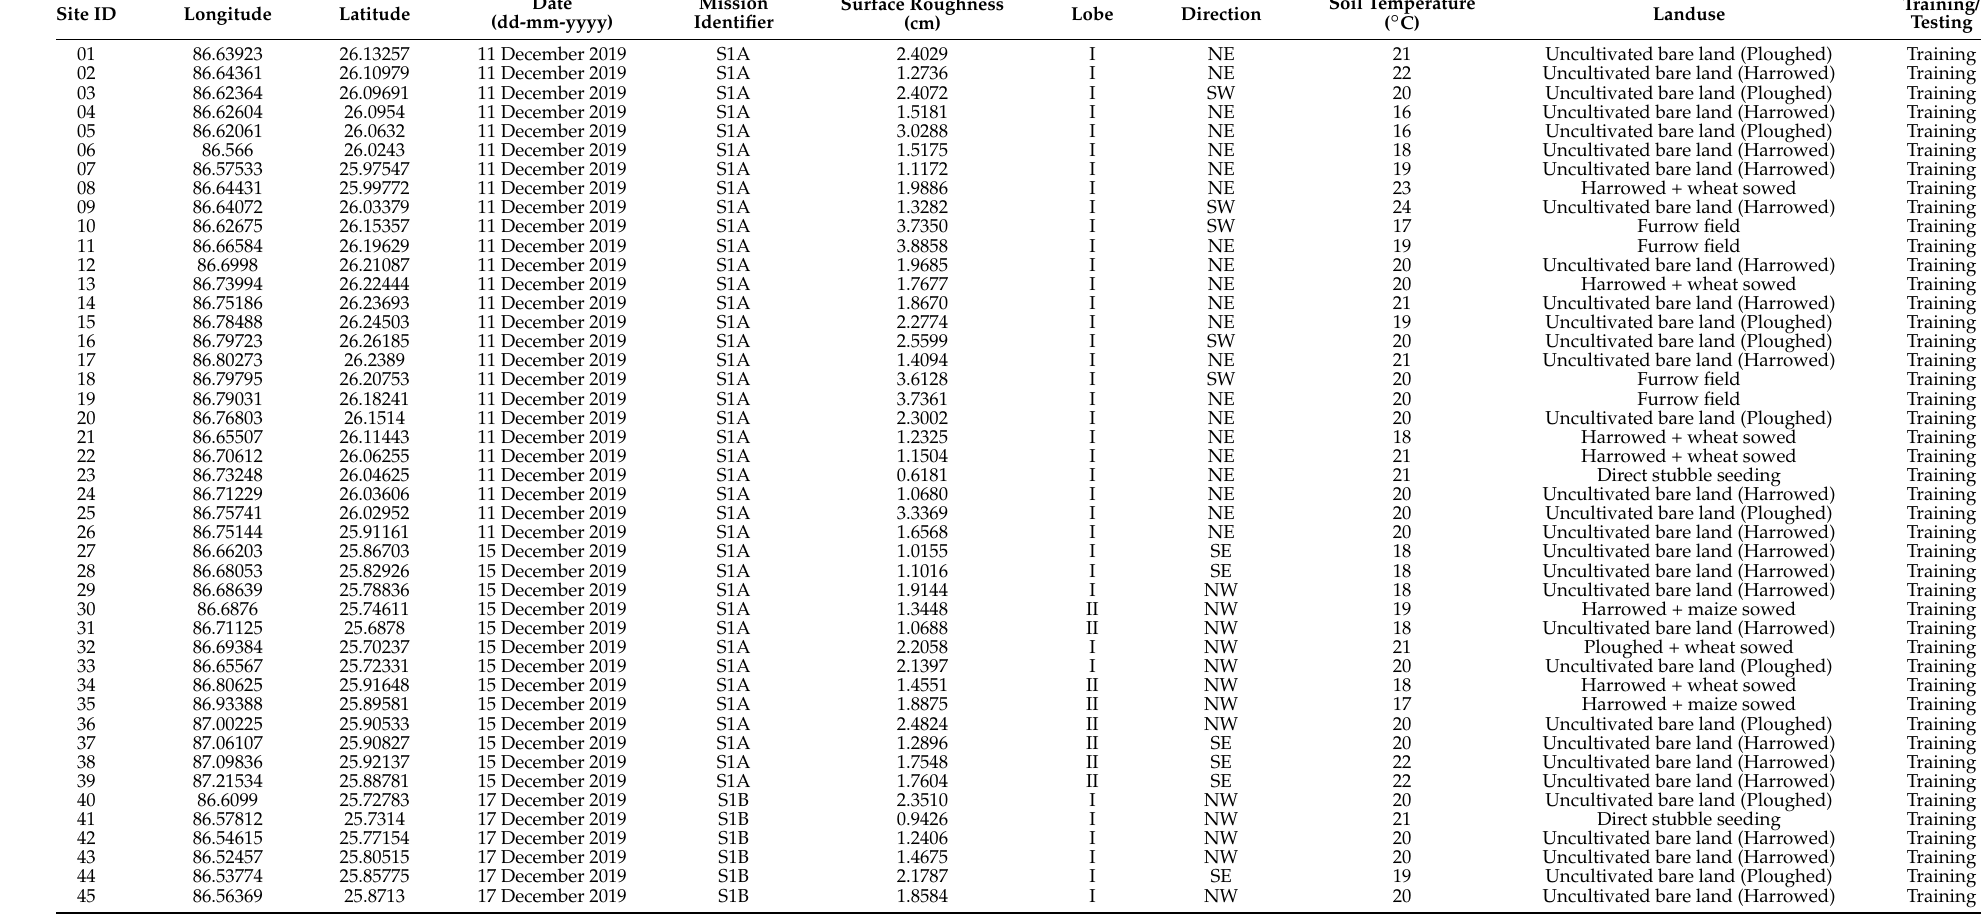
Table A1. Details of the ground condition and surface roughness measured in the